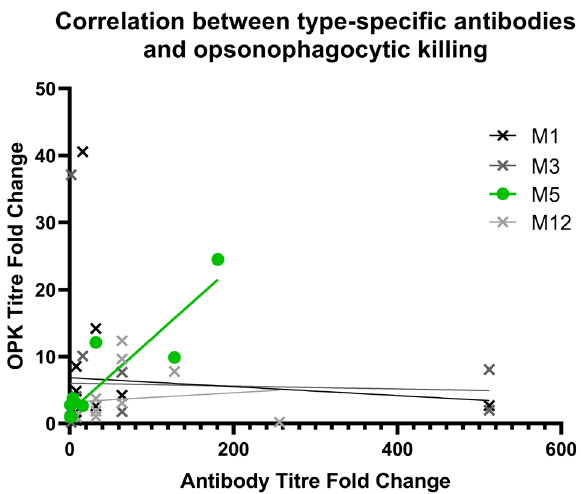
Fig. 2 Correlation between titres of type-speci fi c antibodies and opsonophagocytic killing (OPK) for four different Strep A strains following vaccination with the 30-valent vaccine candidate StreptAnova TM that included M1, M3, M5, M12. A clear correlation is seen between OPK titre and antibody fold changes for M5 (green; R 2 = 0.82), which is not apparent for the other strains. Data are from Pastural et al. 32